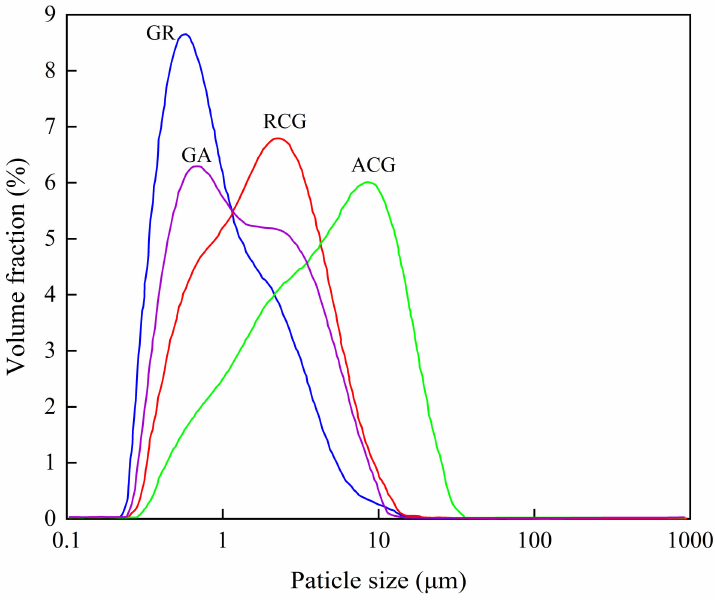
Figure 4. Particle size distribution of coal gangue before and after